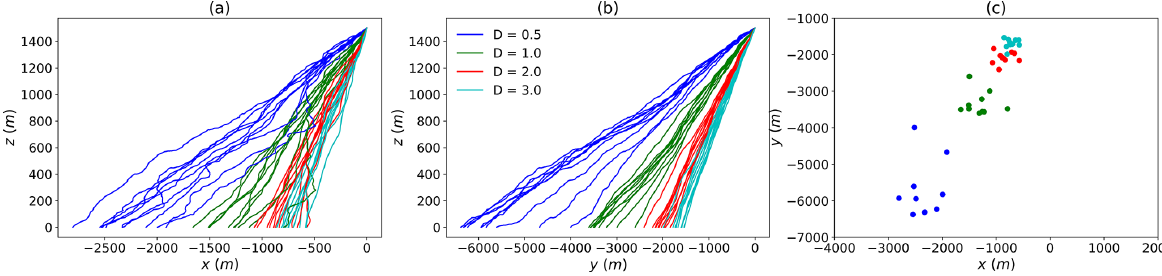
Figure 10. The same as Fig. 9 but for the strong wind event.